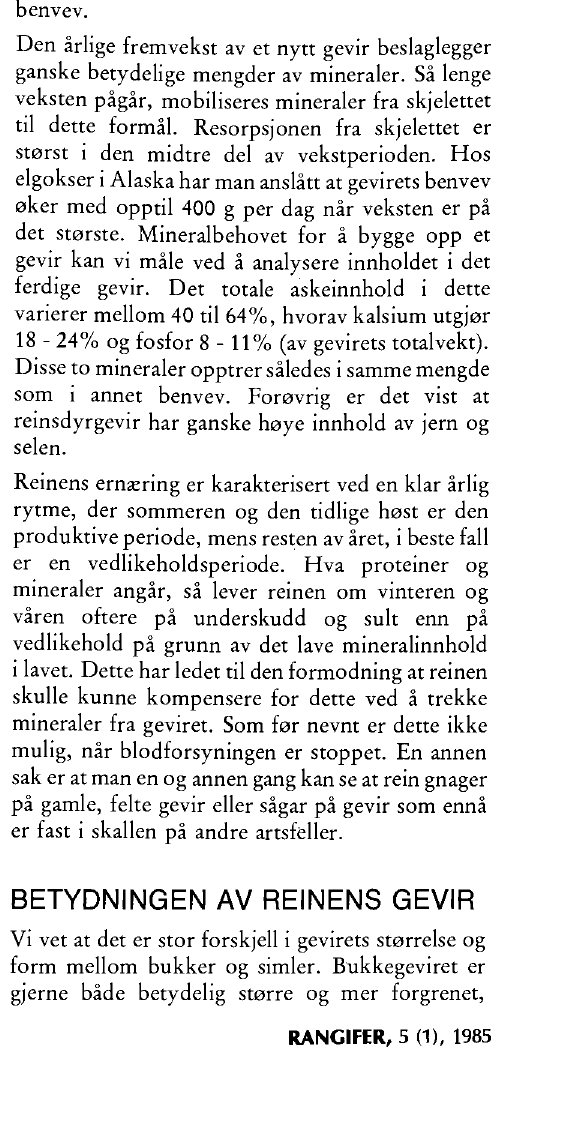
Fig. 2. Reinbukk (sarv) med mangegrenete gevir under brunsttiden. En ristning i horn funnet i Thayngen, Schweiz. Den er mer enn 2000 år gammel (fra Montonen 1974). lingen av det gamle gevir og likeså utviklingen av det nye hos hånlige hjorter. Det er derfor ikke usannsynlig at dette hormon spiller en rolle i å utsette gevirutviklingen også hos drektige simler om våren. Et raskt fall i koriongonadotropin